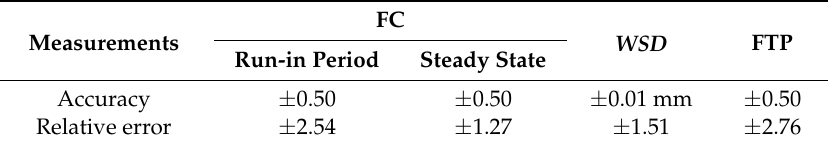
Table 2. Summary of uncertainty related to different